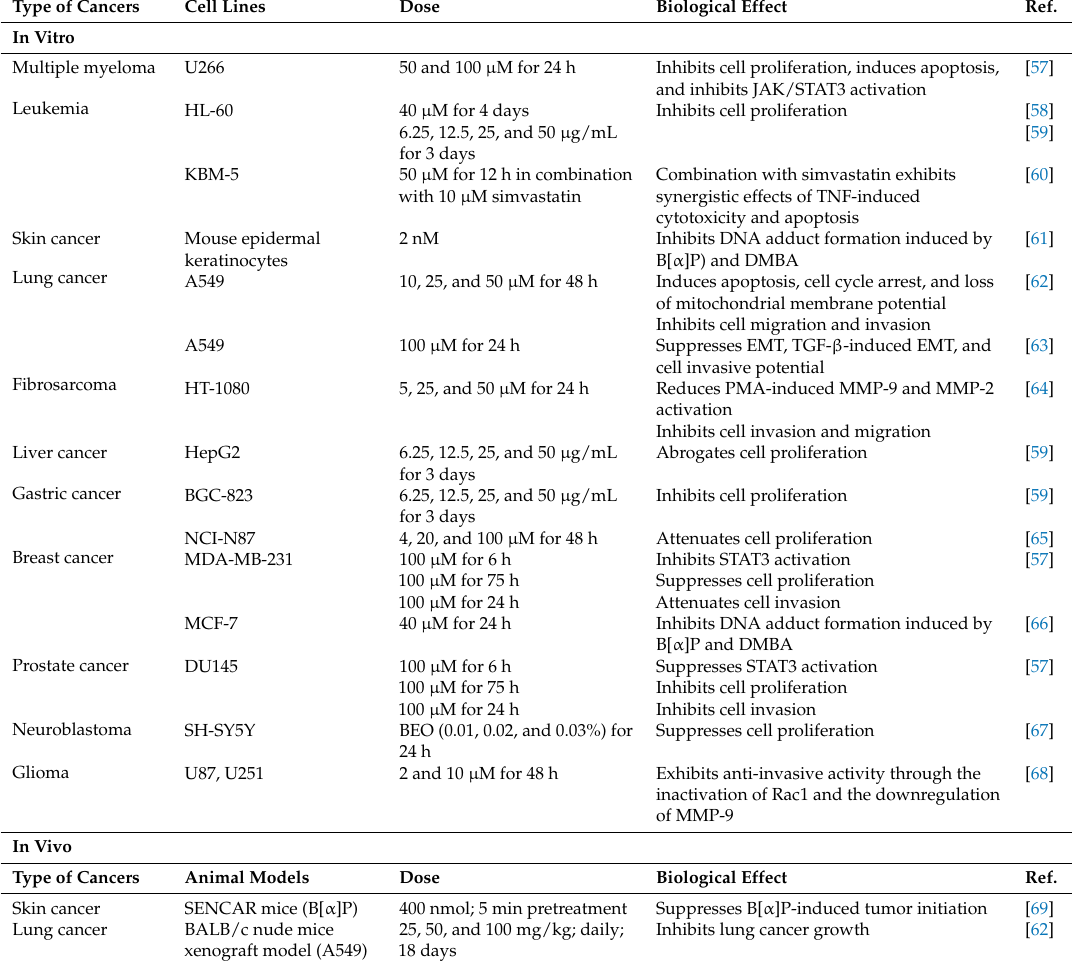
Table 2. In vitro and in vivo effects of bergamottin against